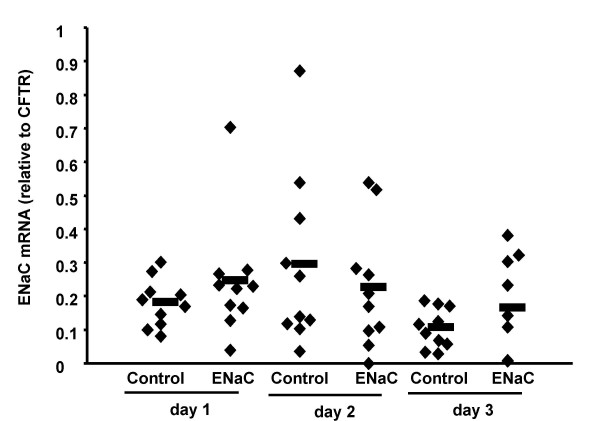
αENaC mRNA in nasal tissue after in vivo transfection with ENaC asODN . αENaC asODN (as5) or a control ODN was complexed to GL67 (80 μg/mouse) and slowly perfused onto the nasal epithelium of mice via a thin catheter. At indicated times after transfection nasal potential difference measurements were carried out (for results see Table 2) and the nasal tissues was harvested for mRNA extraction and quantification of αENaC mRNA. Each diamond represents an individual animal. The mean per group is indicated as a horizontal bar.